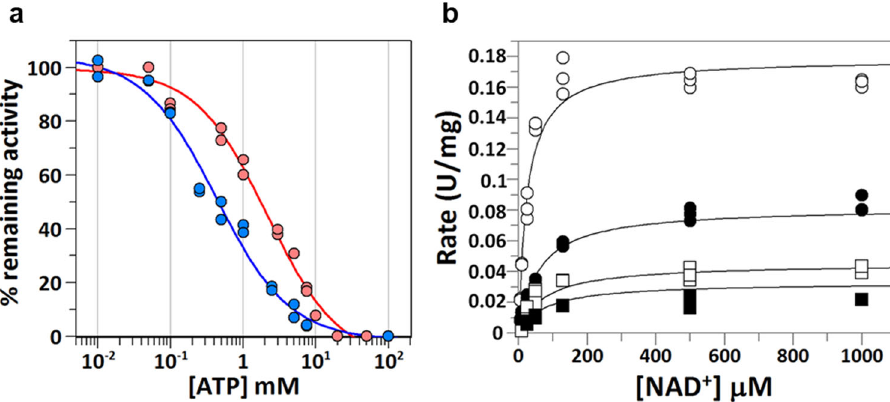
Fig. 7 Inhibition kinetics of ATP against ALDH1A3. a Sigmoidal plots to determine IC 50 values. The ALDH1A3 activity was assayed in 50 mM HEPES, 5 mM DTT, pH 8.0, without MgCl 2 (blue curve) or including 30 mM MgCl 2 (red curve). Hexanal was used as a substrate at saturating concentration (250 µ M). NAD + concentration was 24 µ M in the absence of MgCl 2 , and 130 µ M with 30 mM MgCl 2 . Experimental values with all replicate points are shown. n = 2, technical replicates for each ATP concentration (0.01 – 100 mM). b Michaelis-Menten plots fi tted to the equation for mixed inhibition (Eq. 1). ATP concentrations (mM): 0.0 (empty circles), 2.0 (solid circles), 5.0 (empty squares) and 7.5 (solid squares). Hexanal was used as a substrate at a saturating concentration (250 µ M). The values of kinetic parameters from this fi t were: V ma x = 0.18 ± 0.01 U/mg; K m = 24 ± 2 µ M; K i = 0.48 ± 0.08 mM; K ’ = 1.68 ± 0.12 mM. Experimental values with all replicate points are shown. n = 3, technical replicates for each NAD + concentration (5 – 1000 µ M). i Parameter values are expressed as the calculated value ± standard